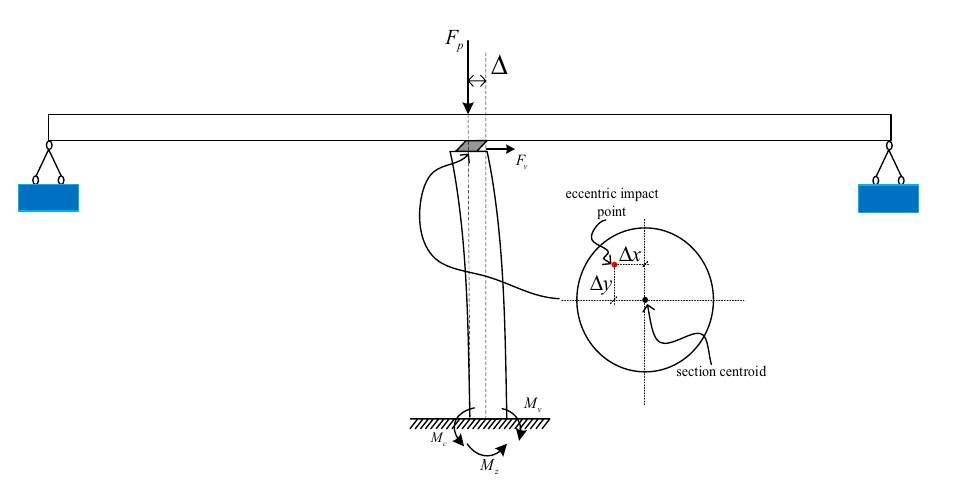
Figure 6. Schematic diagram of the bending moment at the bottom of the